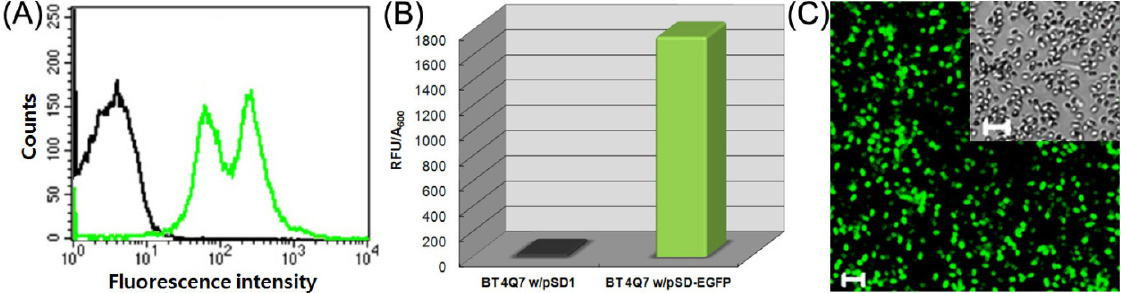
Figure 4. Spore-display of EGFP. ( A ) Flow cytometry analysis. Black line, BT spores harboring pSD1 as a negative control; green line, BT spores harboring pSD-EGFP; ( B ) Fluorescence assay. 1, BT spores harboring pSD1 as a negative control; 2, BT spores harboring pSD-EGFP; ( C ) Confocal microscopy analysis. The inset shows an optical microscopic image. Scale bars represent 5 μ